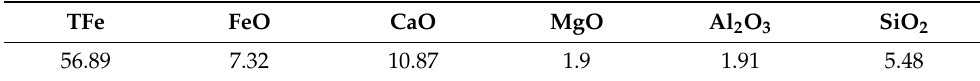
Table 1. Chemical composition of catalyst/wt%.